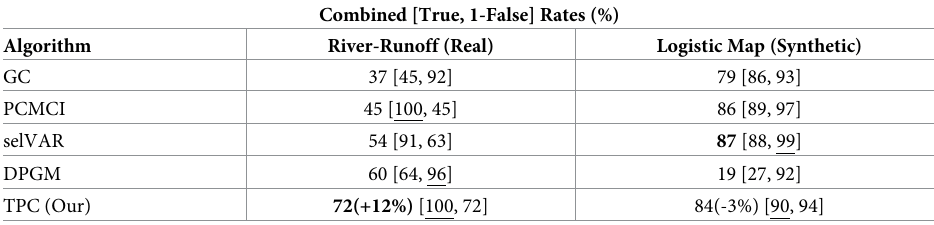
Table 1. Comparison of CFC inference by GC, DPGM, PCMCI-GPDC and selVAR, and TPC on benchmarking datasets. For each dataset, each method’s Combined Score, True Positive Rate, and 1-False Positive Rate are reported (Higher value is